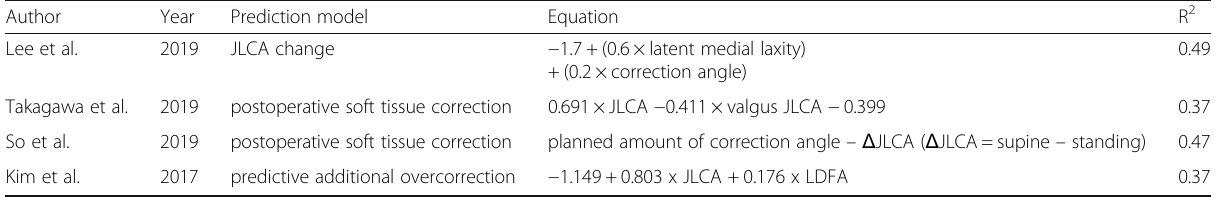
Table 3 Summary of preoperative equations to predict JLCA change or soft tissue correction